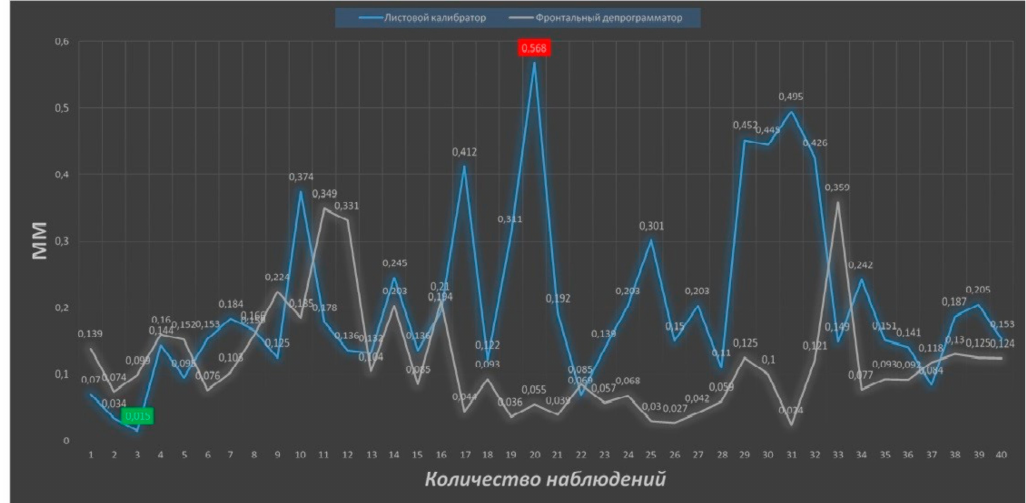
Figure 9. Figure of reproducibility graphic of leaf gauge (blue color) and frontal deprogrammer (grey color). Number of observations at the x-axis, value of deviation in mm at the